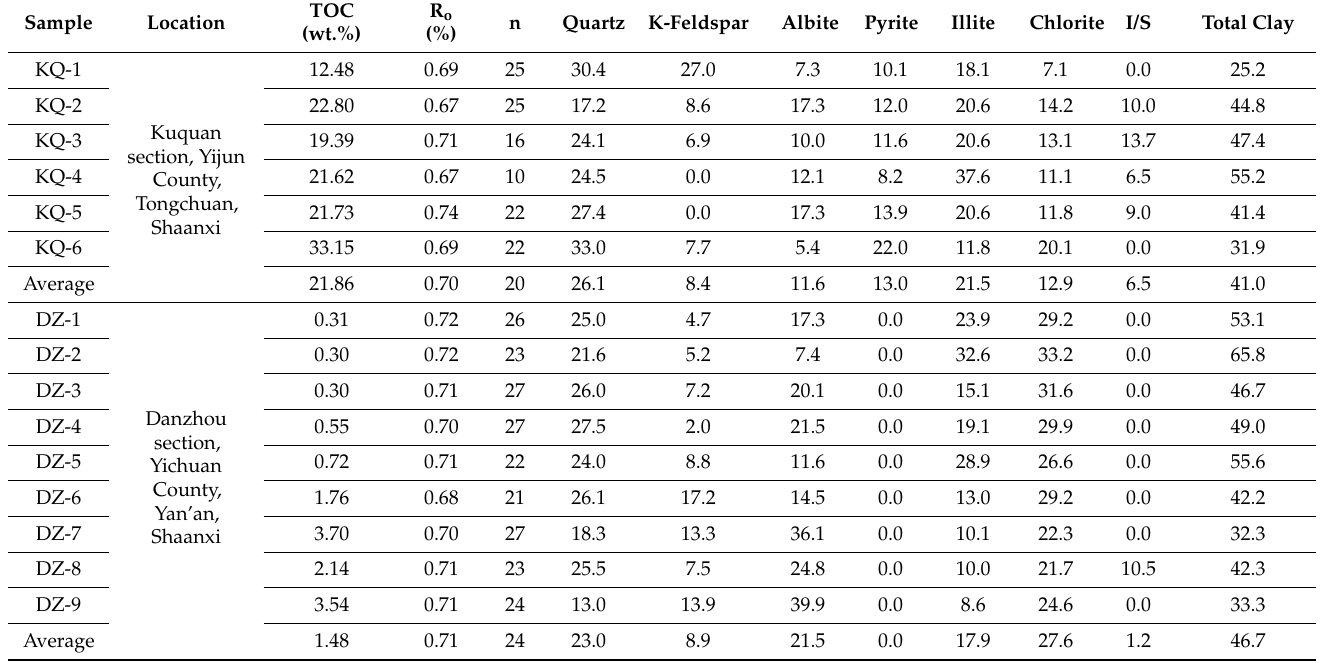
Table 1. Total organic carbon (TOC) content, vitrinite reflectance (R o ), and mineralogical composition of the studied shale